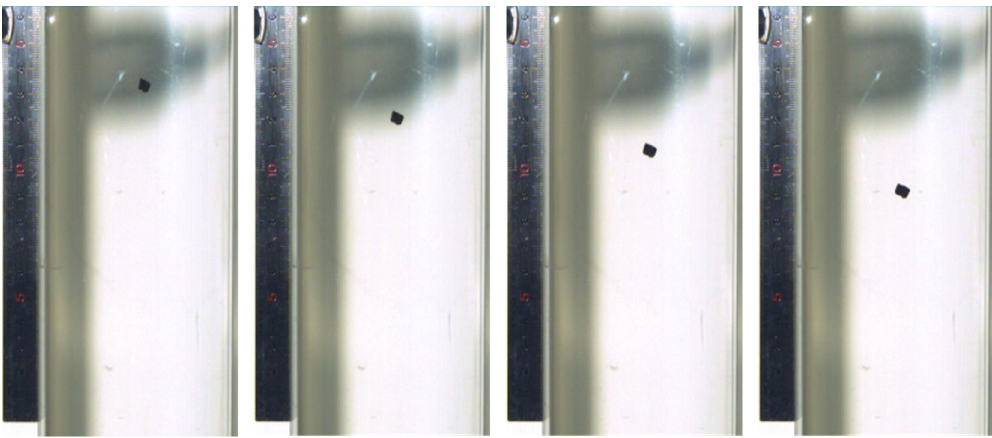
Figure 6. Four consecutive pictures captured during the settlement of shale cuttings.